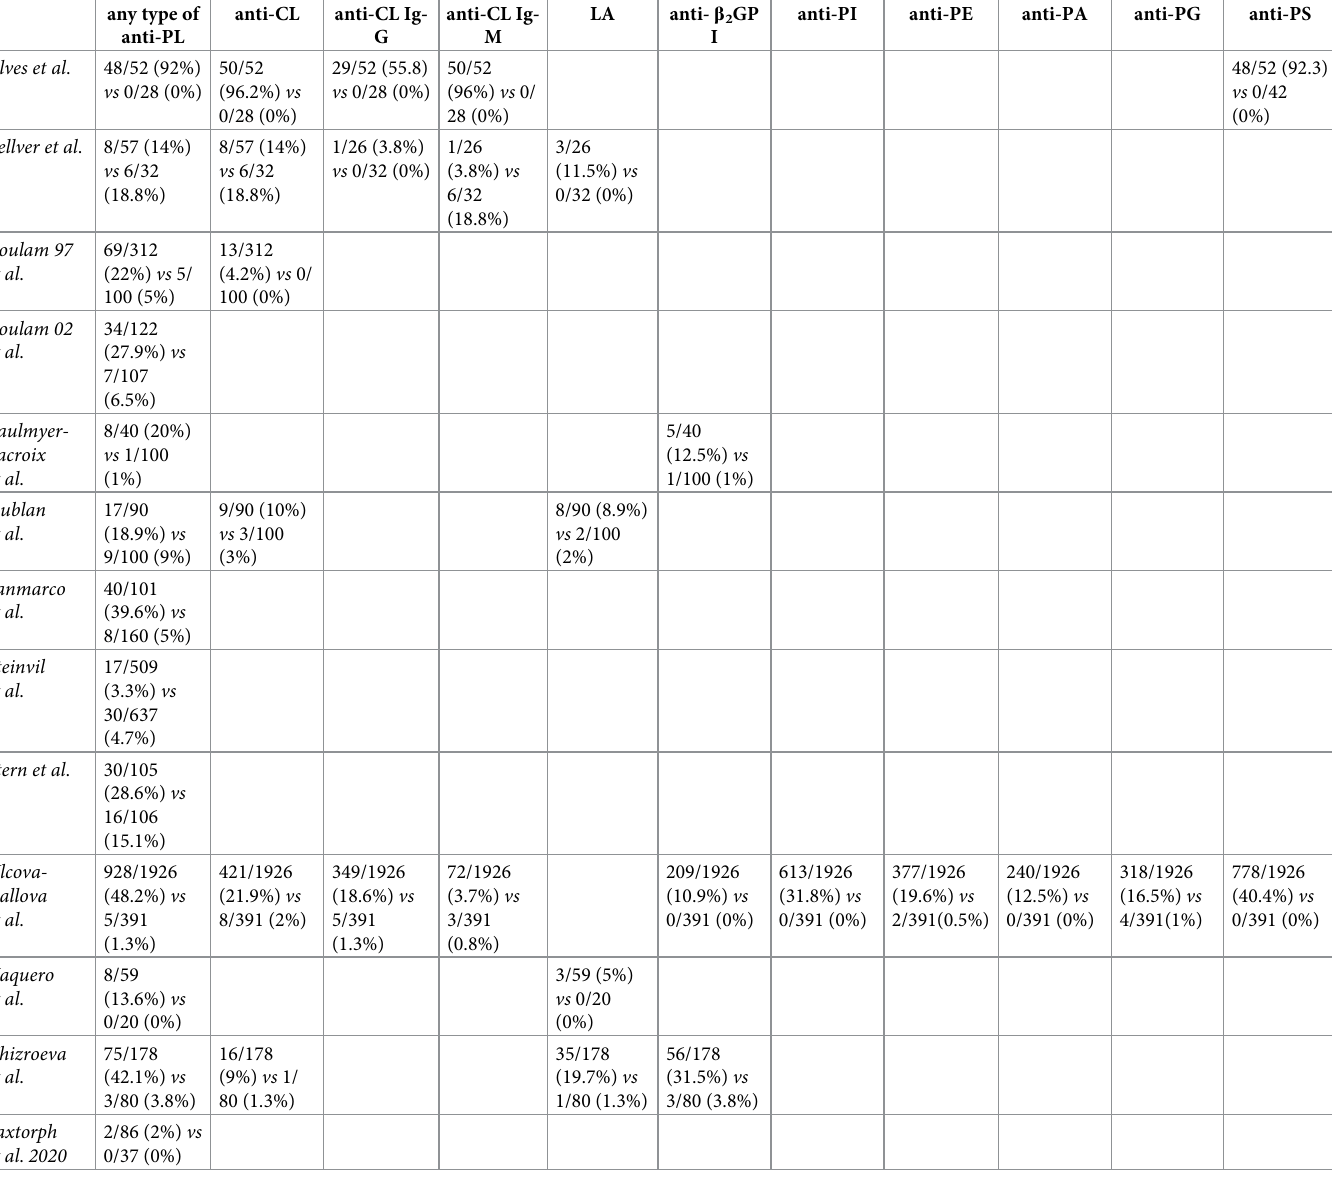
Table 2. Prevalence (reported as percentages in parentheses) of different types of anti-phospholipid (anti-PL) antibodies in studies included in subgroup B of